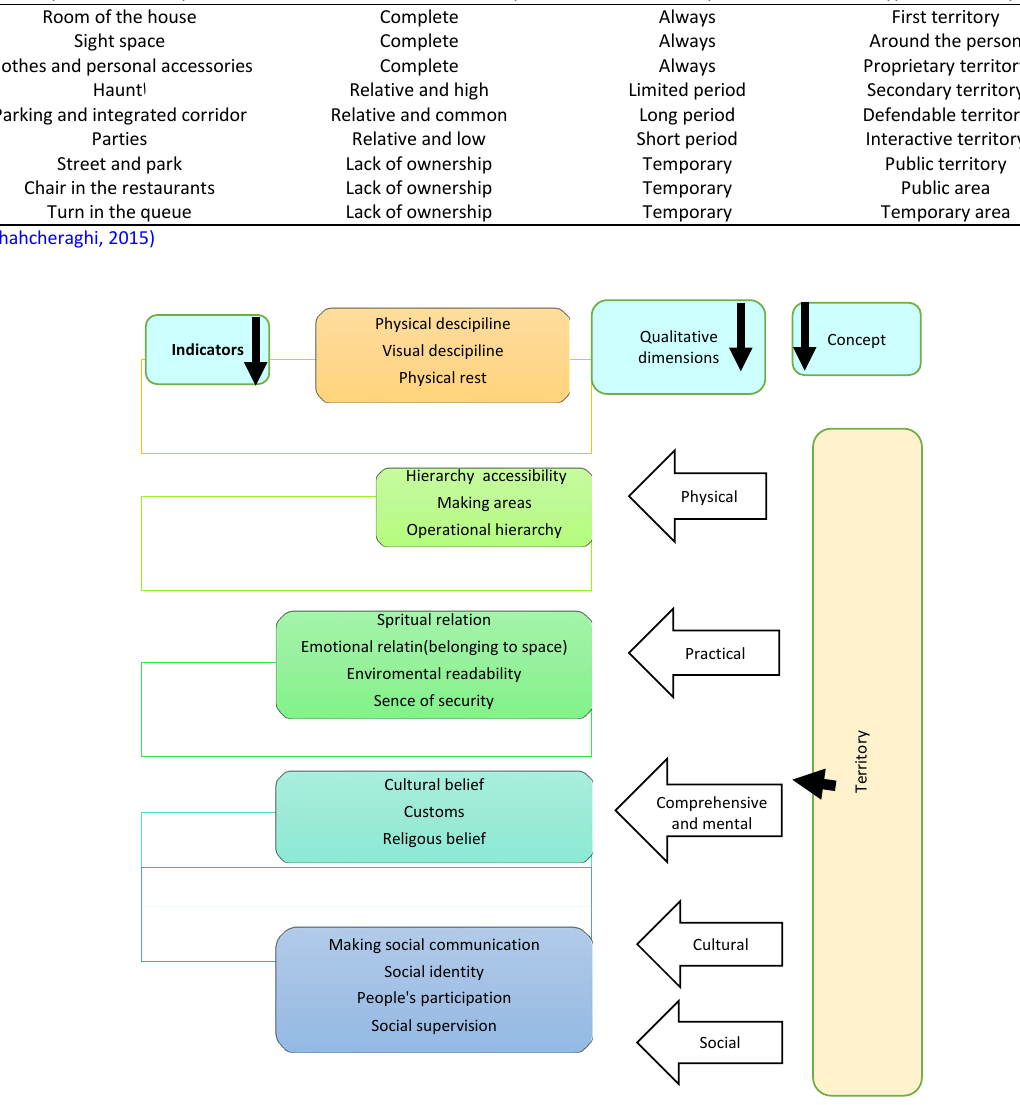
Fig 3: Qualitative indicators of spatial territory formation (Bahreini and Tajbakhsh, 1998)